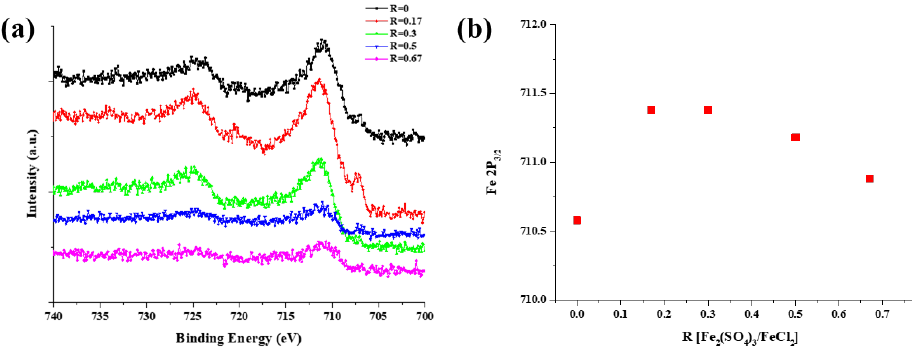
Figure 5. Fe 2p 3/2 X-ray photoelectron spectroscopy (XPS) spectra of substrate after removing the CNT forests with different R values: ( a ) Fe 2p 3/2 spectra, and ( b ) Peak position of Fe 2p 3/2 .